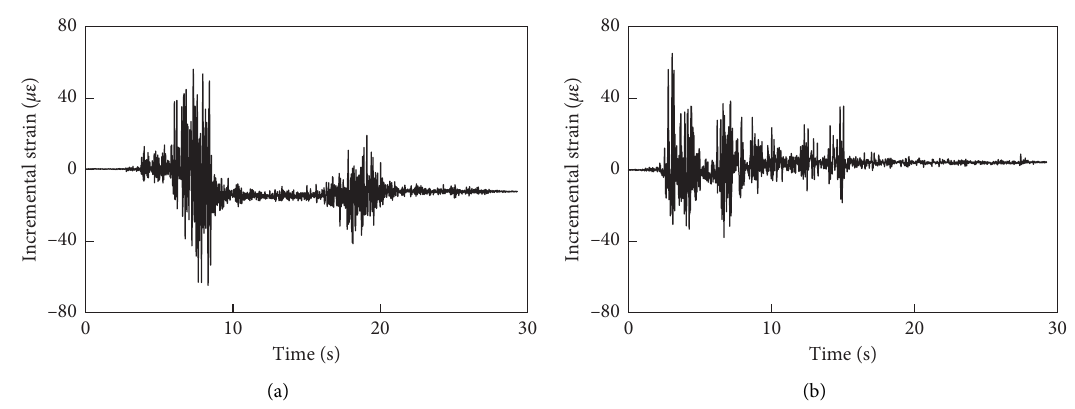
Figure 13: Time history of geogrid strain for specimen 2. (a) Case 13. (b) Case